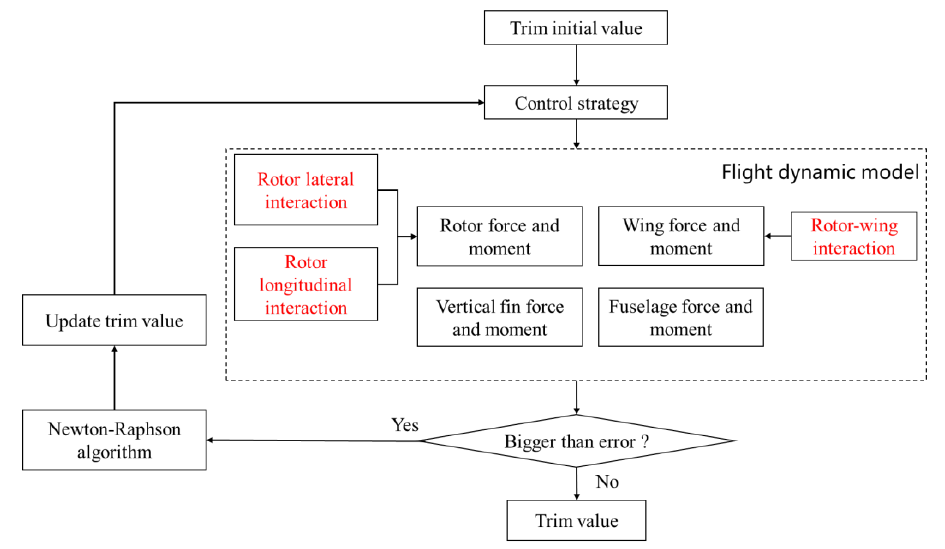
Figure 10. Diagram of the trim calculation procedure.